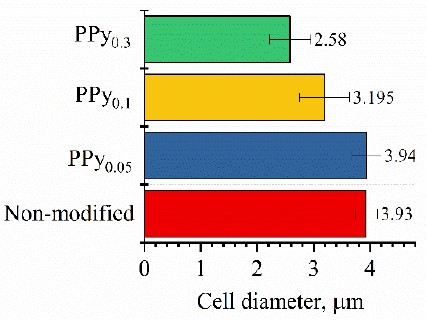
Figure 3. Dependence of cell diameter on the concentration of polypyrrole.